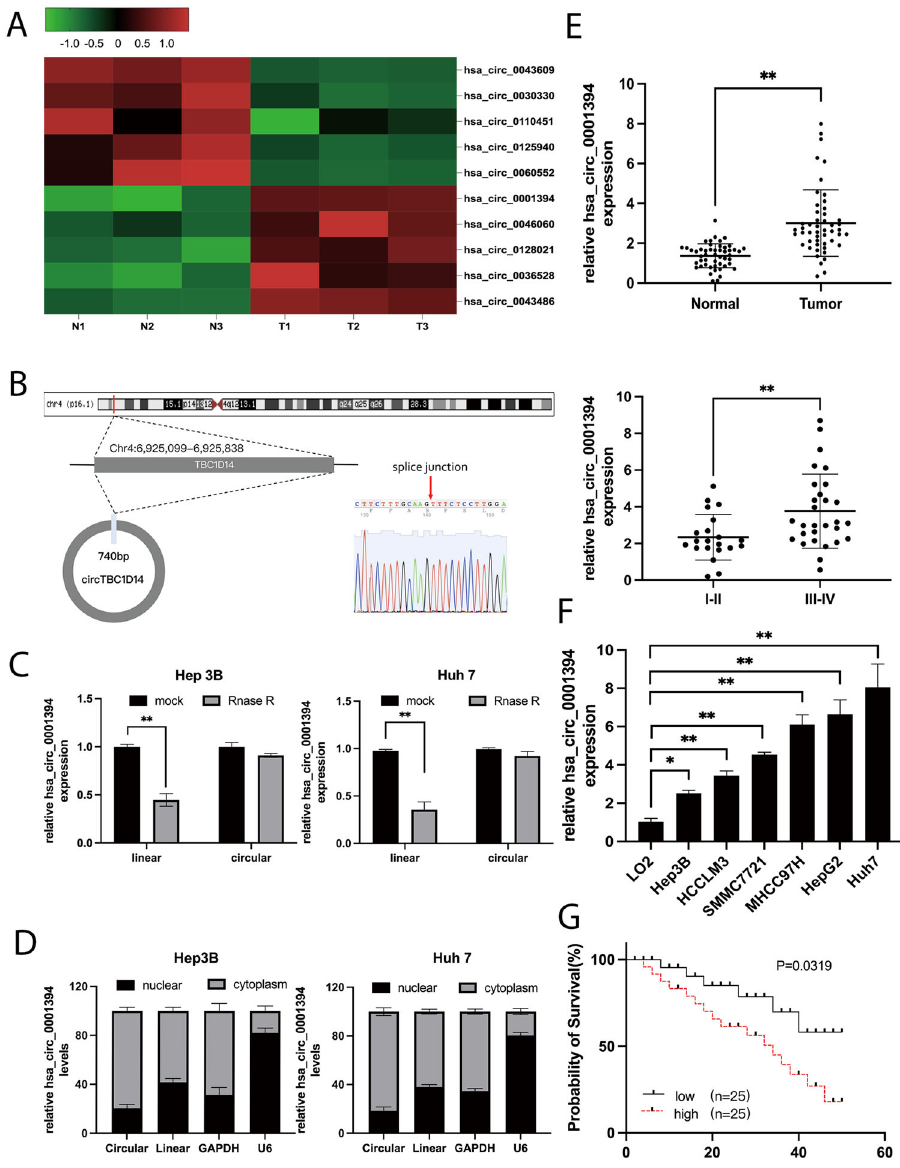
Fig. 1 Upregulation of hsa_circ_0001394 in HCC specimens and cell lines. A Heatmap illustrating the top 5 high and low expressed circRNAs between three pairs of HCC specimens (right) and matched healthy controls (left). B The spliced mature length of hsa_circ_0001394 corresponding to the TBC1D14 gene is 740 bp and the head-to-tail splicing of hsa_circ_0001394 was con fi rmed by Sanger sequencing. C The expression of hsa_circ_0001394 and TBC1D14 mRNA in both Hep3B and Huh7 cells was evaluated by qRT-PCR treated with or without RNase R. Hsa_circ_0001394 rather than linear TBC1D14, resisted digestion by RNase R. D Assessment of the predominant localization of hsa_circ_0001394 using qRT-PCR. Hsa_circ_0001394 was mainly located in the cytoplasm. E Evaluation of relatively various expression levels of hsa_circ_0001394 between 50 pairs of HCC specimens and matched paracarcinoma tissues according to qRT-PCR. The expression of hsa_circ_0001394 was higher in HCC specimens than in control specimens. Expression of hsa_circ_0001394 in different clinical stages of HCC samples according to qRT-PCR. The expression of hsa_circ_0001394 in early stage (I – II) HCC was markedly lower than that in advanced-stage (III – IV) HCC. F Assessment of relative hsa_circ_0001394 expression in six HCC cell lines (Hep3B, HCCLM3, SMMC7721, MHCC97H, HepG2, and Huh7) compared to that in normal liver cells (LO2) according to qRT-PCR. G The 50 HCC samples were divided into high and low groups according to hsa_circ_0001394 expression. Kaplan – Meier survival analysis indicated that the group with high hsa_circ_0001394 expression had a lower overall survival ( p = 0.0319) than the group with low hsa_circ_0001394 expression. All values are presented as mean ± SD from three independent experiments with similar results. (* p < 0.05, ** p < 0.01, *** p < Western blotting 2 h. The membranes were then incubated with primary antibodies at 4 °C HCC tissues and cells were lysed with RIPA buffer containing phenyl- overnight. Afterward, the secondary antibody was added, and the methanesulfonyl fl uoride on ice for 20 min and quanti fi ed using a BCA membranes were incubated for 2 h at room temperature. Subsequently, protein assay kit. The proteins were separated via 10% sodium dodecyl an enhanced chemiluminescence (ECL) system (Thermo Fisher Scienti fi c) sulfate – polyacrylamide gel electrophoresis (SDS-PAGE) and transferred was used to evaluate the protein expression levels. The primary antibodies onto polyvinylidene di fl uoride (PVDF) membranes (Millipore, Bedford, MA, used in this experiment included anti-UBE2A (Abcam, #ab31917, 1:1000), USA) and the membranes were blocked with 5% nonfat milk powder for anti-E-cadherin (Abcam, #ab1416, 1:1000), anti-N-cadherin (Abcam,